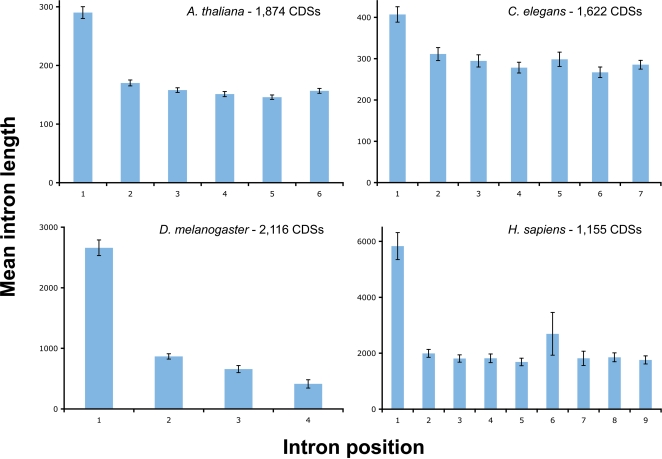
Intron size variation for selected species with different numbers of introns.Intron lengths are shown for species with CDSs that contain 4, 6, 7 or 9 introns (in D. melanogaster, A. thaliana, C. elegans, and H. sapiens respectively). Bars on graph show standard error of the mean. Numbers of CDSs used for each species are shown.